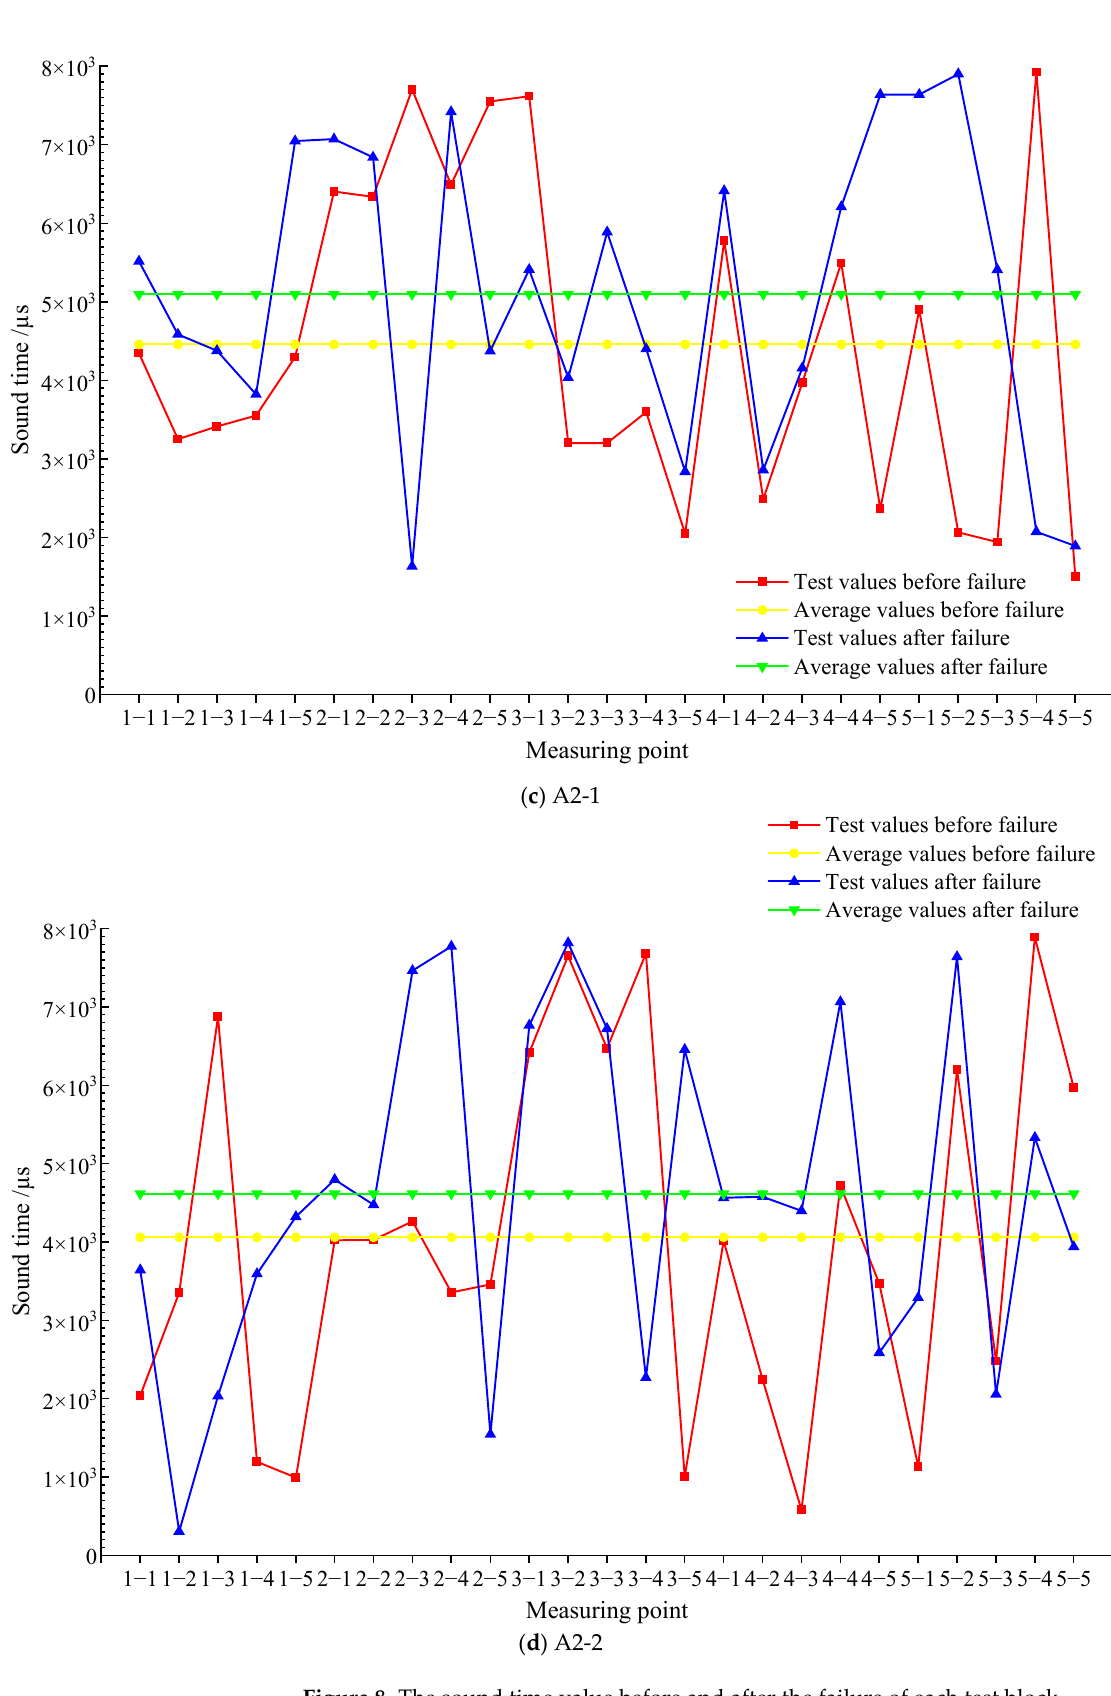
Figure 8. The sound time value before and after the failure of each test